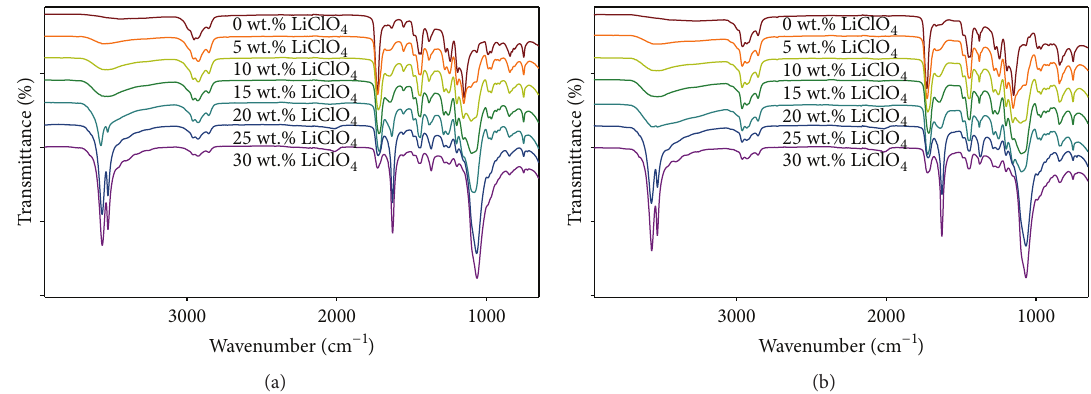
Figure 2: IR absorption spectra: (a) [MG49- 𝑥 wt.% LiClO 4 ]:[8.0 wt.% HNO 3 -THF/TiO 2 -SiO 2 ] and (b) [MG49- 𝑥 wt.% LiClO 4 ]:[8.0 wt.% ClHNO 2 -THF/TiO 2 -SiO 2 ] polymer electrolytes.